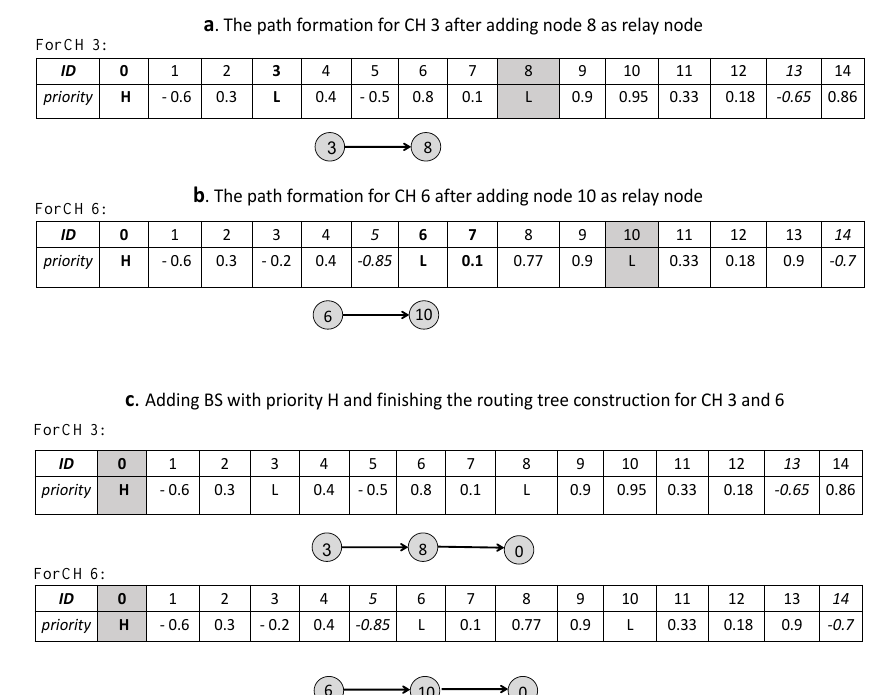
Figure 5. A simple example of modified tree encoding: ( a ) initialization of encoding particles for Figure 4 based on a random-priority number between [ − 1, 1], ( b ) encoding particles after adding CH 3 to the routing tree, and ( c ) encoding particles after adding CH 6 to the routing tree.